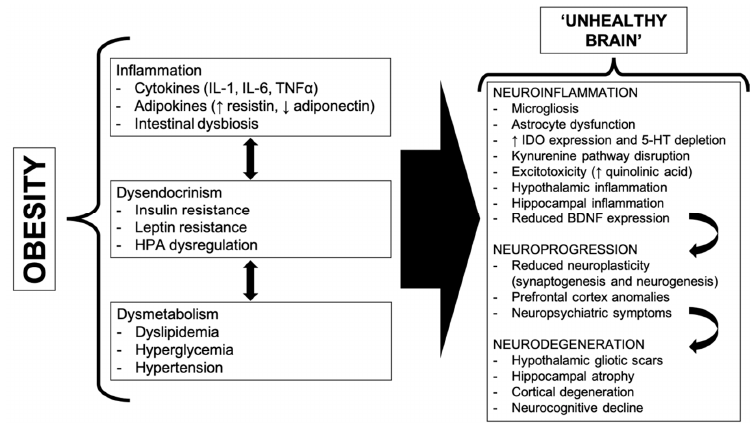
Figure 1. Theoretical model attempting to delineate some of the most significant pathobiological mechanisms, currently thought to explain the link between obesity and brain function. Acronyms—IL-1—interleukin 1; IL-6—interleukin 6; TNF α —tumor necrosis factor alpha; HPA—hypothalamus– pituitary–adrenal; IDO—indoleamine-2; 3-dioxygenase; 5-HT—5-hydoxytriptamine; BDNF—brain derived neurotrophic factor.